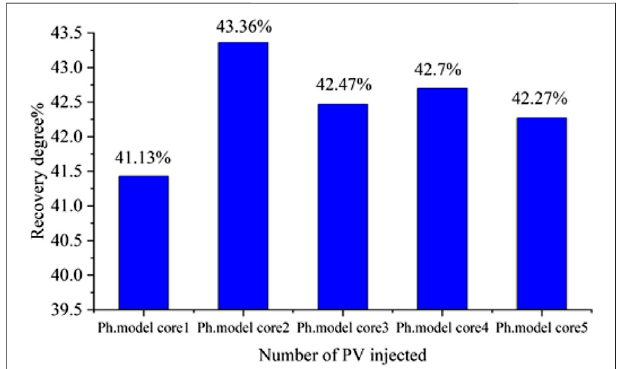
FIGURE 10 | Histogram of the extraction degree comparison of the object